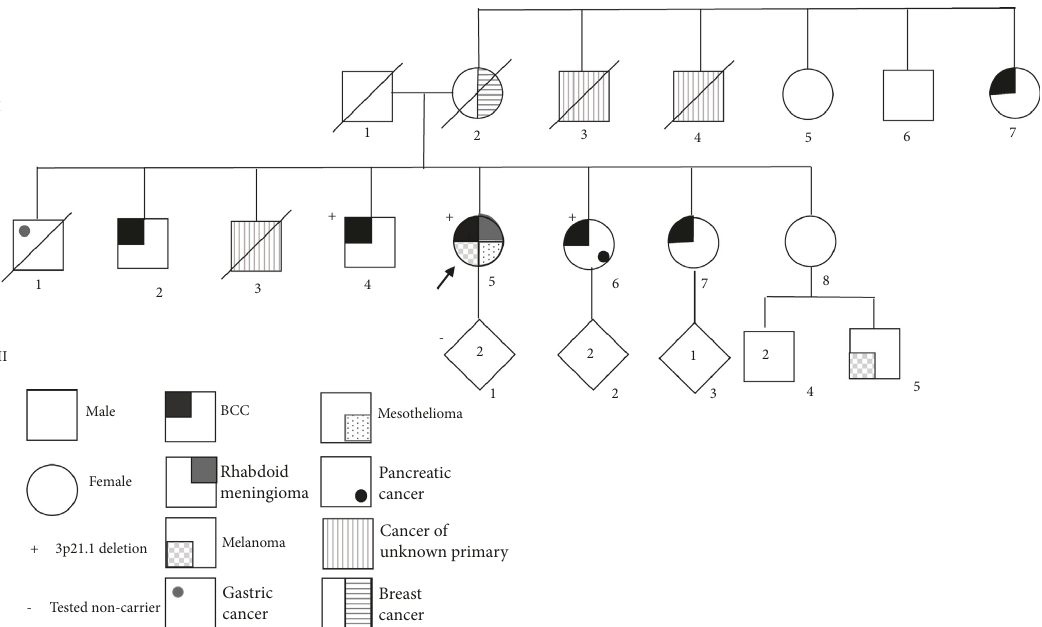
Figure 1: Details of her family cancer history and the results of available family segregation testing for the 3p21.1